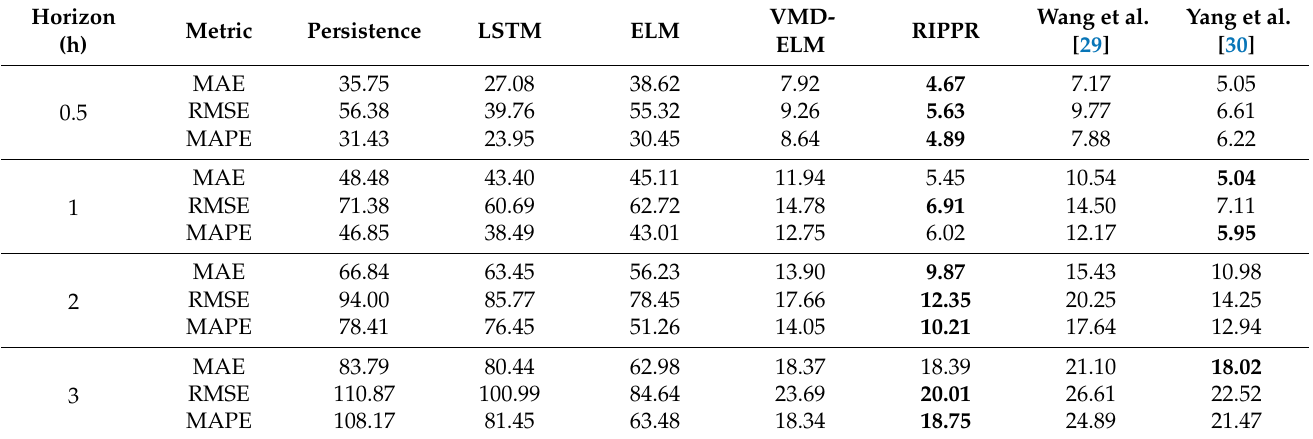
Table 2. Results comparison for dataset